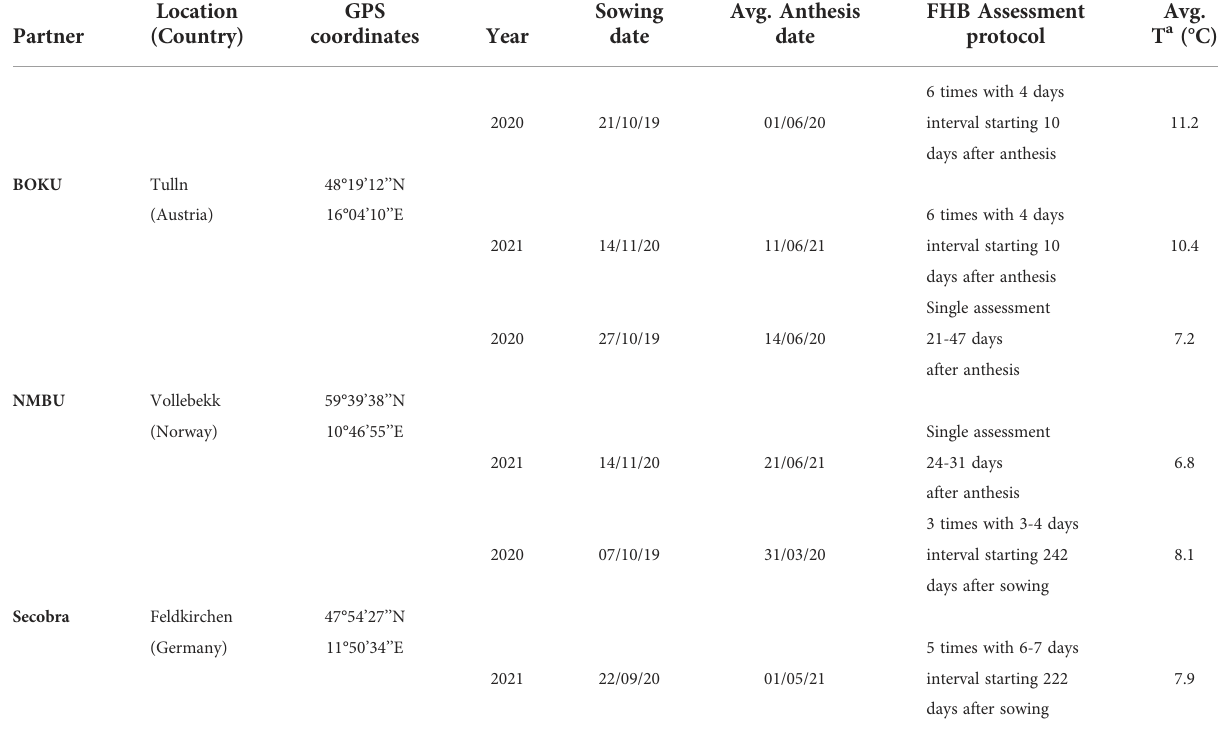
TABLE 1 Partners ’ trial